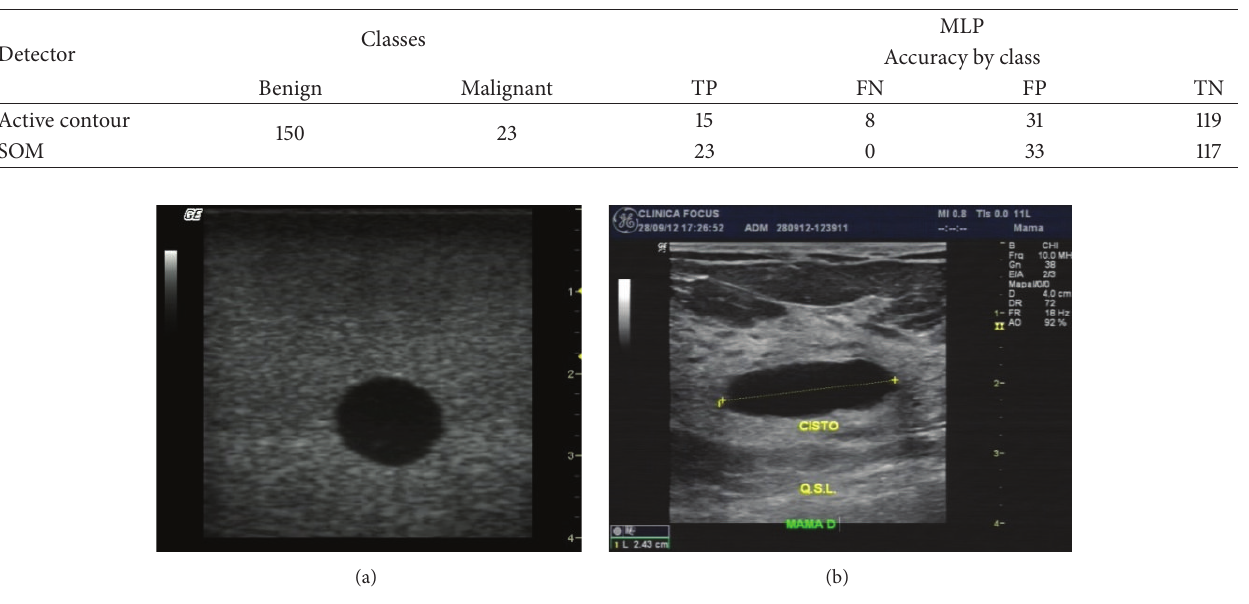
Figure 11: Example of a morphological difference between (a) phantom image and (b) actual clinical exam.